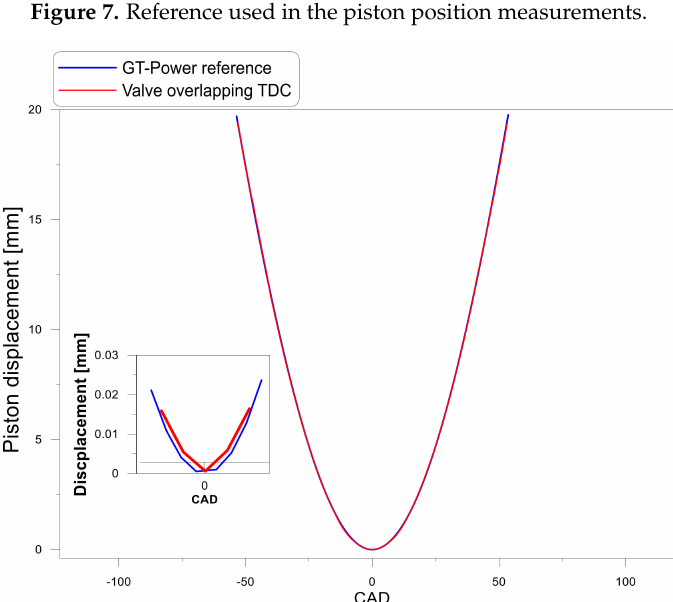
Figure 8. Measured piston displacement versus the calculated